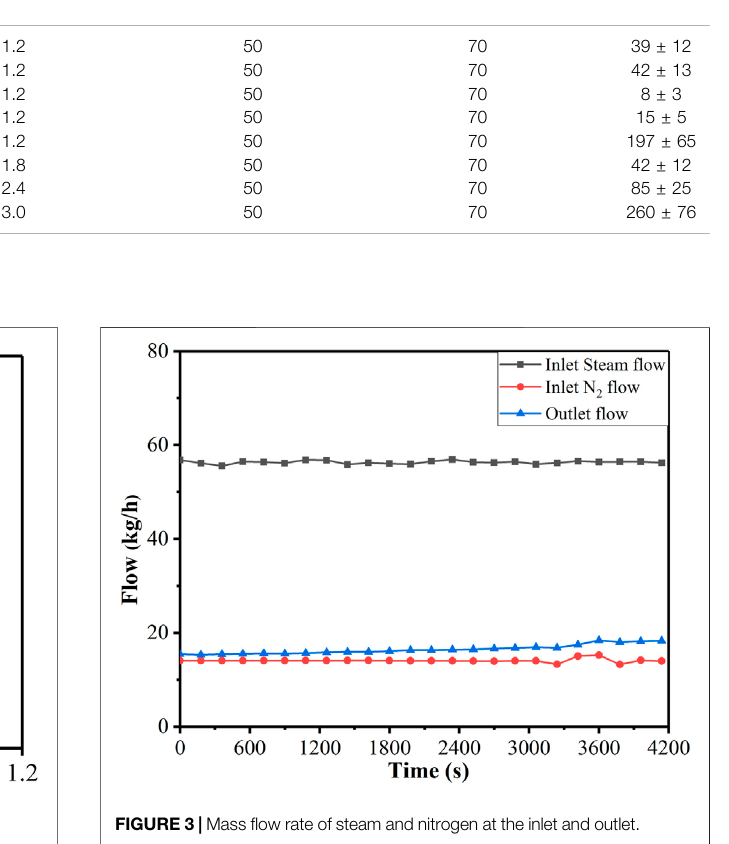
FIGURE 2 | The DFs of different particle diameters in SF1 and SF1-R.